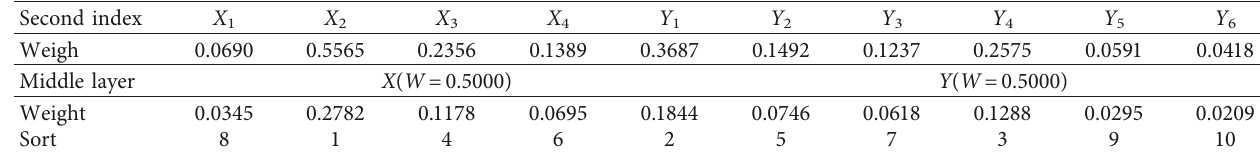
Table 6: Ranking weight and combination weight of first-level indicators.